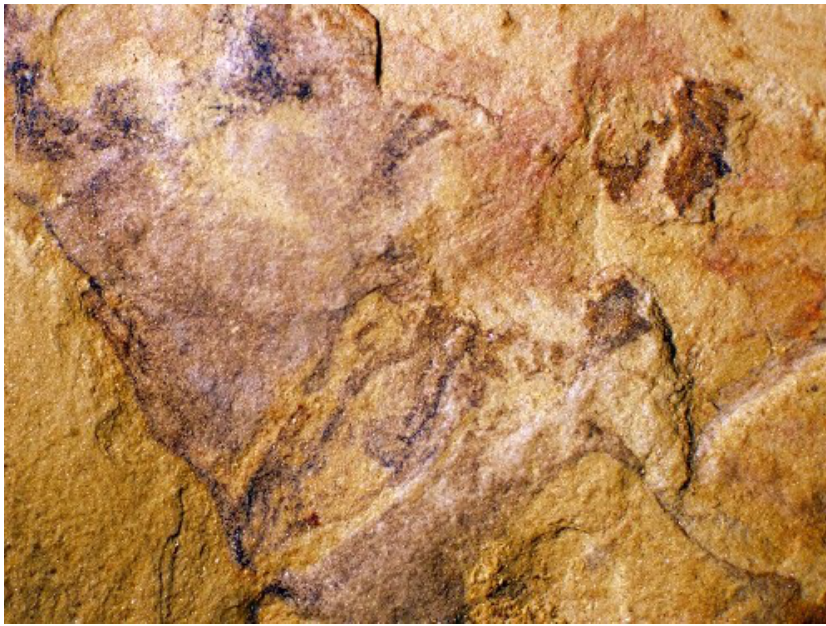
Figure 17. Shenzianyuloma yunnanense nov. gen. nov. sp. IGM 5008. Detail of filamentous gill structure. Photo Credit: Mark McMenamin.